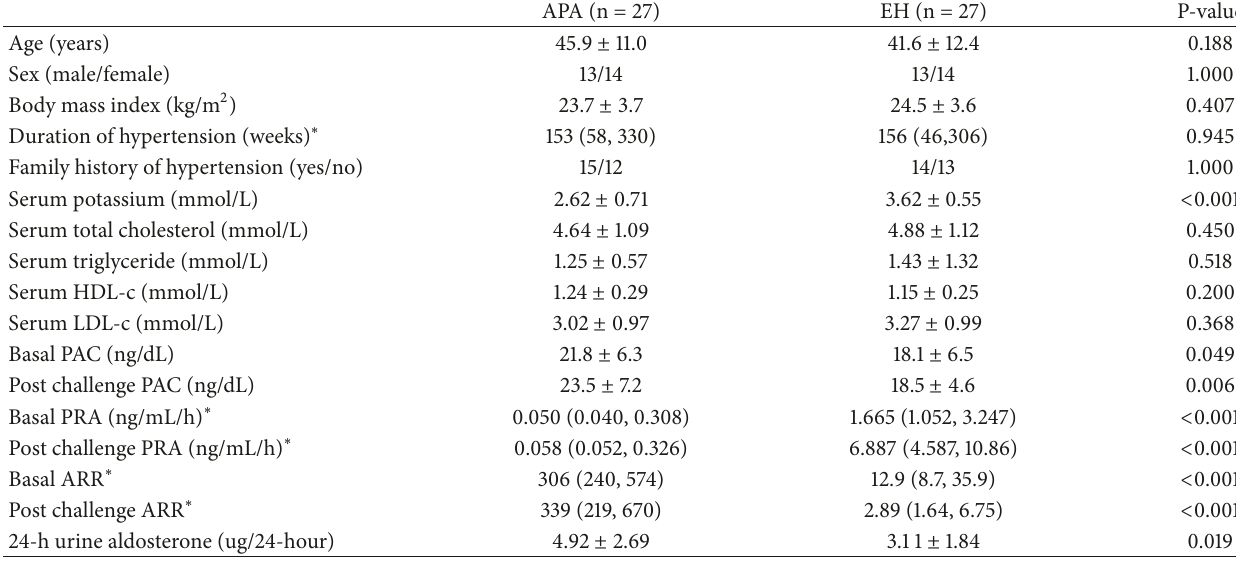
Table 1: Demographic and biochemical values in patients with aldosterone-producing adenoma and essential hypertension.